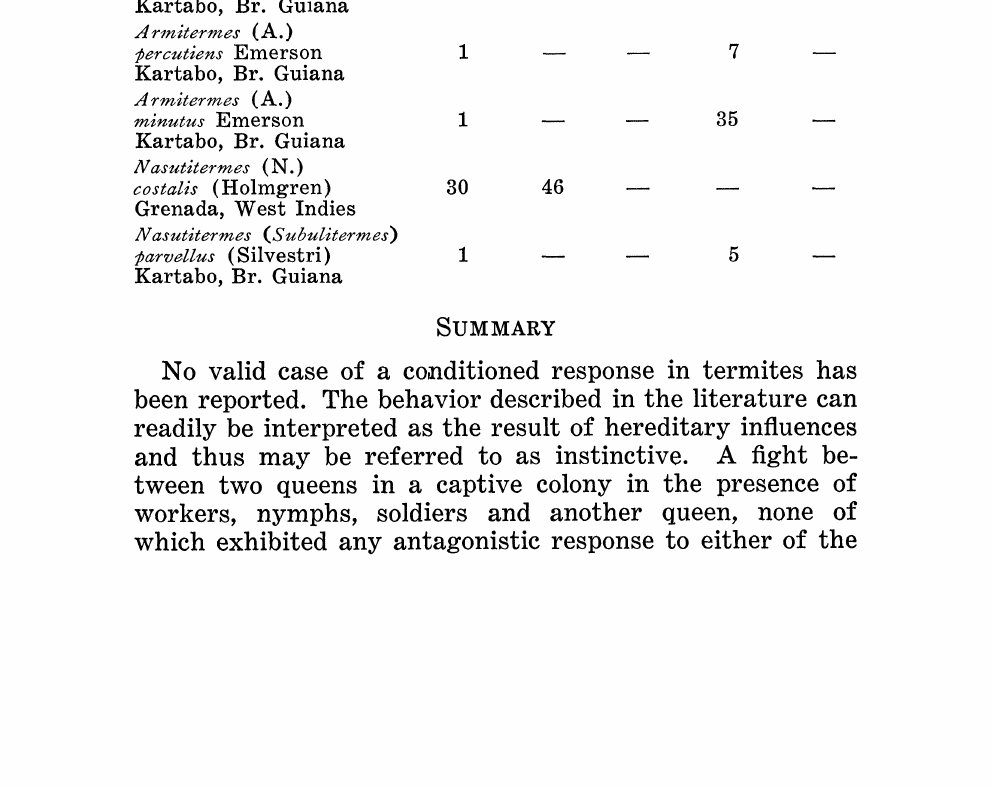
Records of reproductive castes found living together in the same nest. Numbers refer to the number of each caste collected. 1st form 1st form 2d form 2d form 3d form king queen king queen queen Reticulitermes ]lavi$es (Kollar). Cold